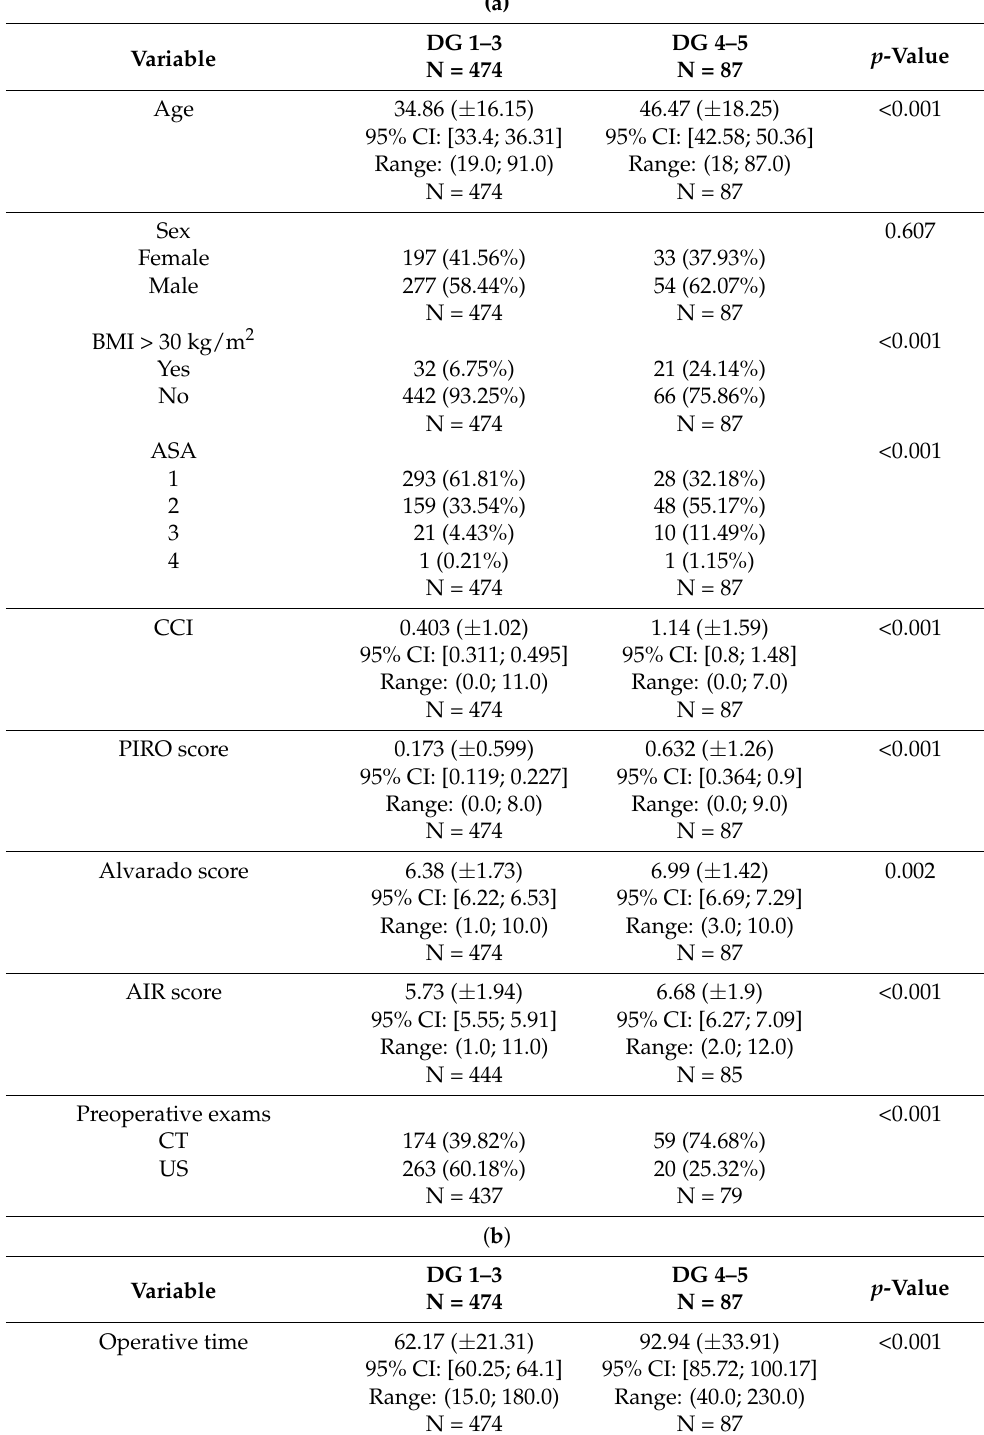
Table 1. ( a ) Comparison analysis considering preoperative variables between procedures with DG 4–5 and without needing external help (DG 1–3). DG, difficulty grade; BMI, body mass index; ASA, American Society of Anaesthesiology classification; CCI, Charlson comorbidity index; PIRO score, predisposition insult response organ dysfunction score; AIR score, appendicitis inflammatory response score; CT, computed tomography; US, ultrasound. ( b ) Comparison analysis considering intraoperative variables between procedures with DG 4–5 and without needing external help (DG 1–3). ( c ) Comparison analysis considering postoperative variables between procedures with DG 4–5 and without needing external help (DG 1–3). SSI, surgical site